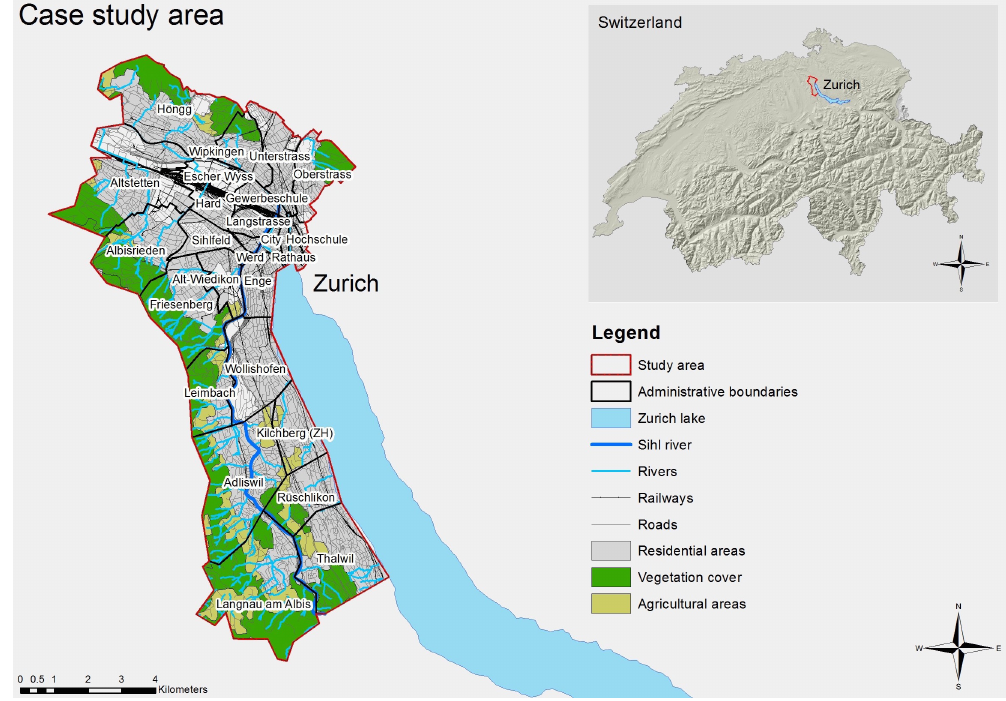
Figure 2. Case study area. Note: map produced by Martina Bullo, available in Ronco et al. (2015).